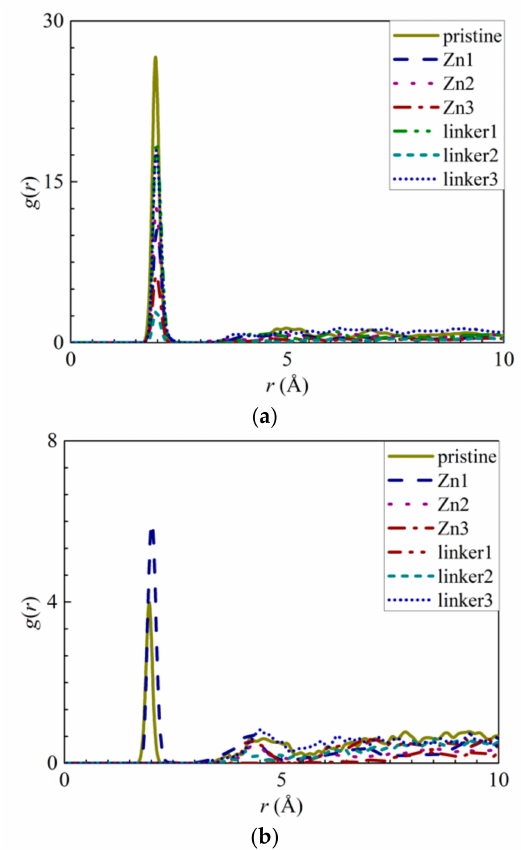
Figure 5. RDFs of the respective ZIF-8s: ( a ) Na + ions around the nitrogen atoms and ( b ) Cl − ions around the Zn